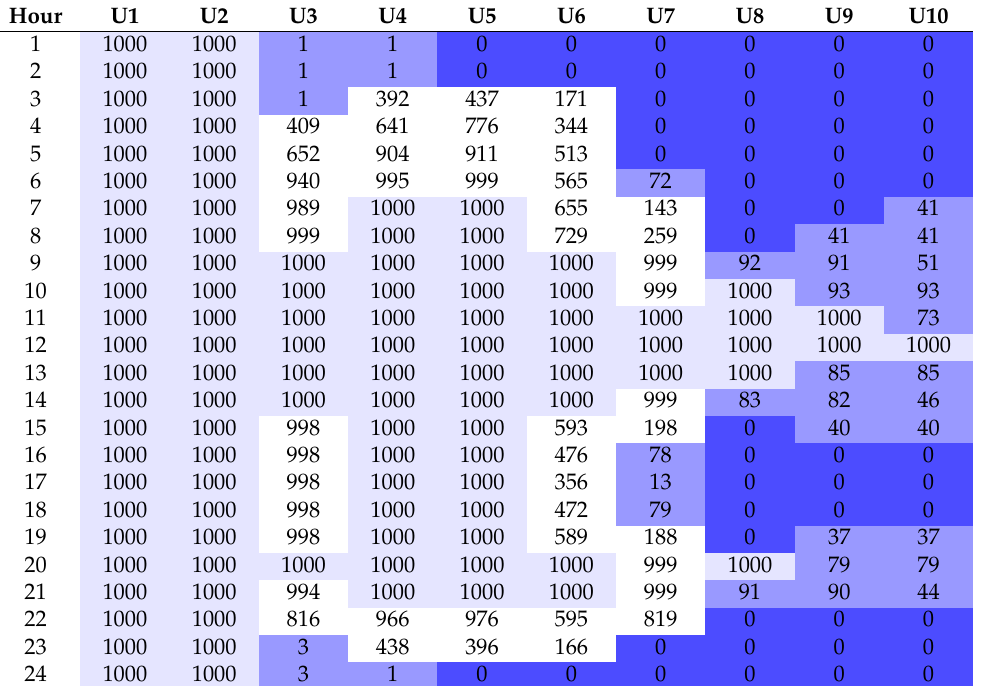
Table 6. RM for 10